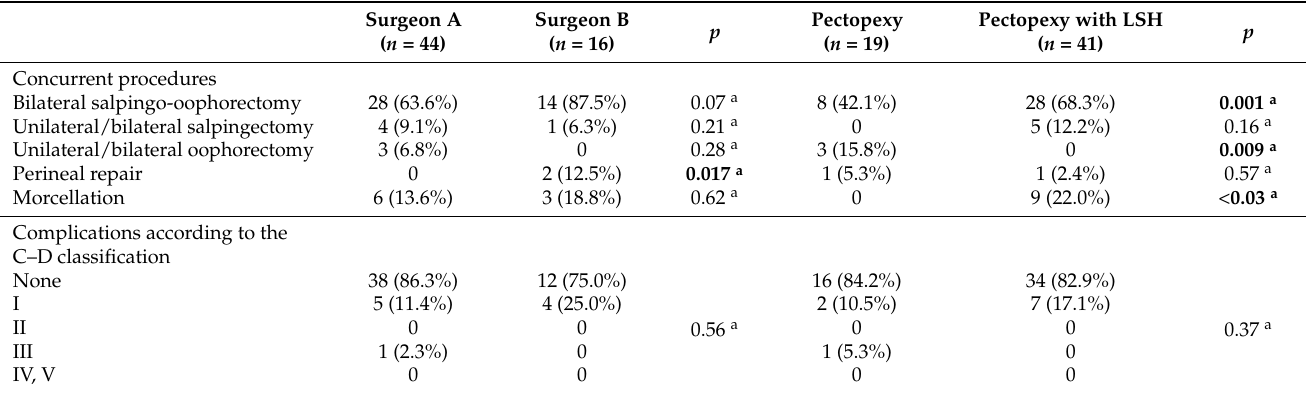
Table 2. Concurrent procedures, reoperations, and perioperative complications according to the C–D classification in groups of